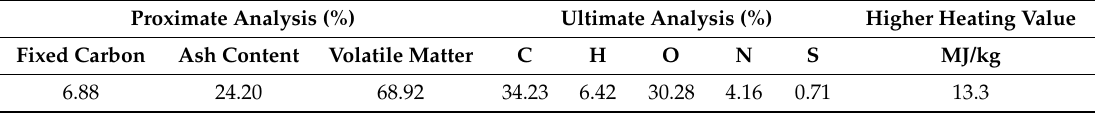
Table 1. Proximate, ultimate and heating value analyses of biosolid (dry